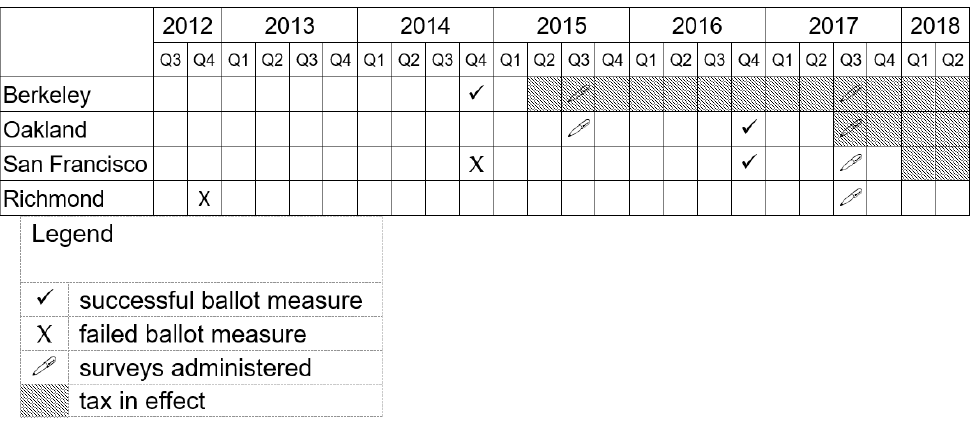
Figure 1. Timeline of SSB ballot measures, tax implementation, and study data collection, 2014–2019.